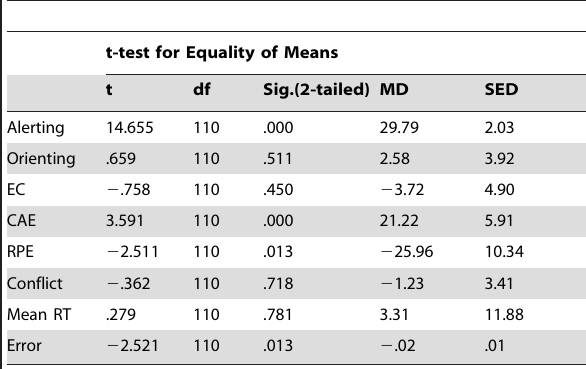
Table 2. Independent-samples t-test based on alerting level